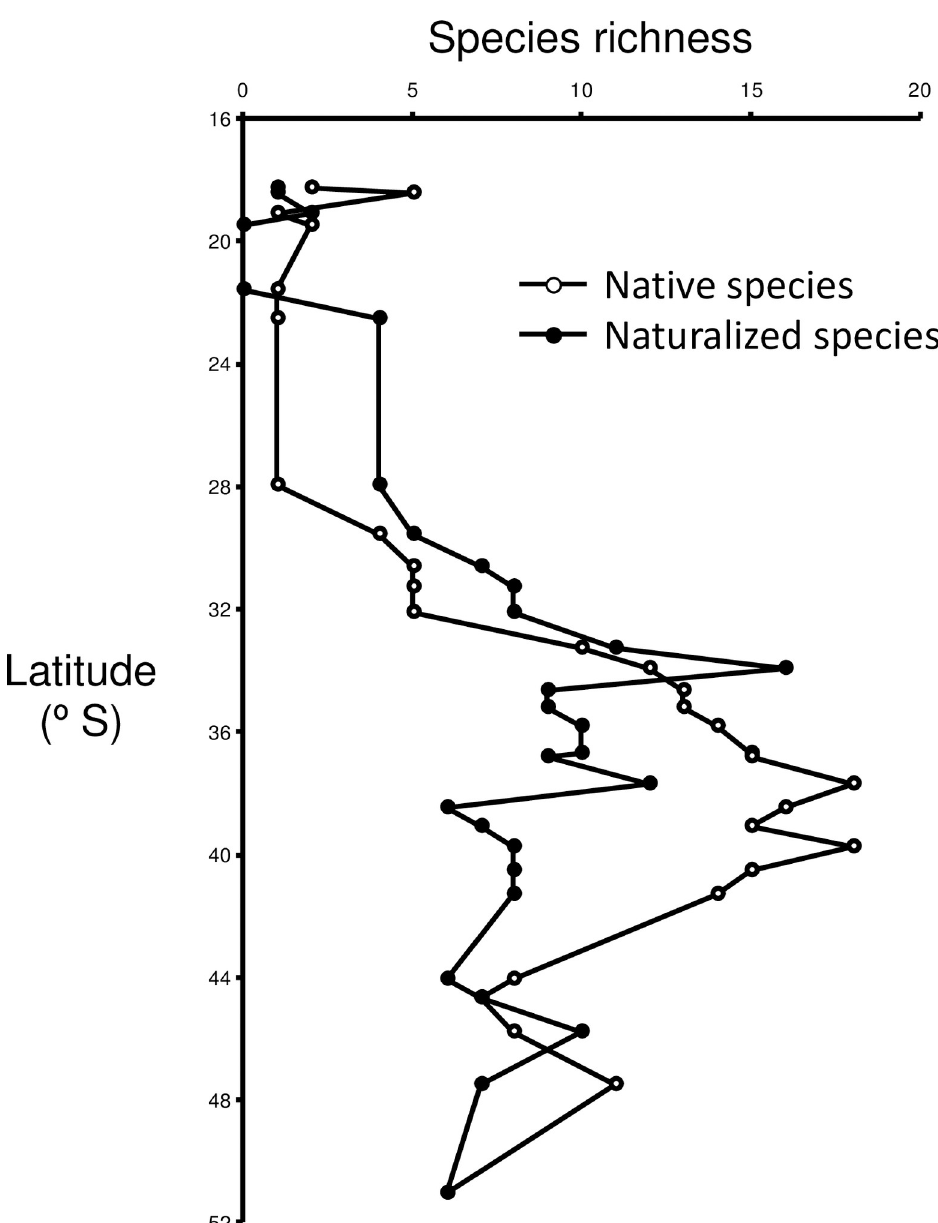
Fig 2. Native and naturalized species richness on Chilean basins according to latitudinal